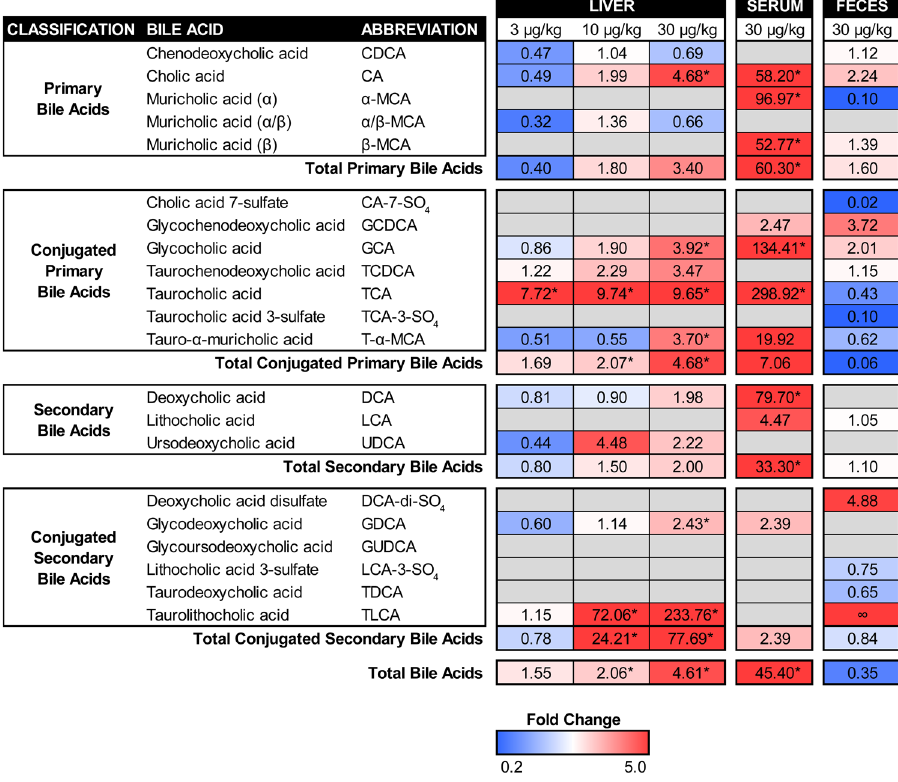
hepatic conjugated primary bile acid levels (max 4.7-fold), including glycocholic acid (GCA; 3.9-fold), tauro- cholic acid (TCA; 9.7-fold), and tauro- α -muricholic acid (T- α -MCA; 3.7-fold) (Fig. 4). Paradoxically, hepatic expression of Baat , which is responsible for hepatic taurine- and glycine-conjugation of bile acids, was repressed 12.0-fold (Fig. 3). In female mice, TCDD increased hepatic taurine (max 1.4-fold; p = 0.05) and glycine (max 20.3-fold; p = 0.10) levels 36 . TCDD repressed hepatic expression of taurine biosynthesis genes including cysteine dioxygenase 1 ( Cdo1 ; 2.7-fold) and cysteine sulfinic acid decarboxylase ( Csad ; 4.5-fold), while the taurine trans- porter Slc6a6 (encoding TAUT) was induced 1.8-fold (Supplementary Table S1), suggesting hepatic taurine uptake rather than de novo synthesis. Furthermore, TCDD elicited a dose-dependent increase in total hepatic levels of conjugated secondary bile acids (max 77.7-fold), suggesting increased bacterial metabolism. More spe- cifically, TLCA, the most induced hepatic bile acid, was dose-dependently increased 72.1- and 233.8-fold at 10 and 30 µ g/kg TCDD, respectively (Fig. 4). Individual bile acids differ in their capacity to bind hepatic receptors. TLCA is the most potent endogenous activator of GPBAR1, a metabotropic bile acid receptor located on non-parenchymal cells including Kupffer cells, sinusoidal epithelial cells, and bile duct epithelial cells (cholangiocytes) 28 . Using qRT-PCR, hepatic Gpbar1 expression was induced 4.3-fold at 30 µ g/kg TCDD (Supplementary Fig. S2). Increased hepatic TLCA levels com- bined with Gpbar1 induction would promote activation of GPBAR1 following TCDD treatment. Likewise, CDCA is the most potent endogenous FXR agonist, while T- α -MCA and T- β -MCA are competitive antagonists 37 . At low hepatic CDCA levels due to conversion to α -MCA, TCDD-elicited increases in T- α -MCA levels may inhibit FXR activation. Moreover, TCDD repressed hepatic Nr1h4 (encodes FXR) 3.2-fold, further inhibiting the FXR signaling pathway (Supplementary Table S1). Total bile acids in serum increased 45.4-fold at 30 µ g/kg TCDD (Fig. 4). Taurine- and glycine-conjugates of CA exhibited increases of 298.9- and 134.4-fold, respectively. CA, α -MCA, and β -MCA were the most abundant species present in treated serum samples with increases of 58.2-, 97.0-, and 52.8-fold, respectively. Additionally, the secondary bile acid deoxycholic acid (DCA) was increased 79.7-fold.